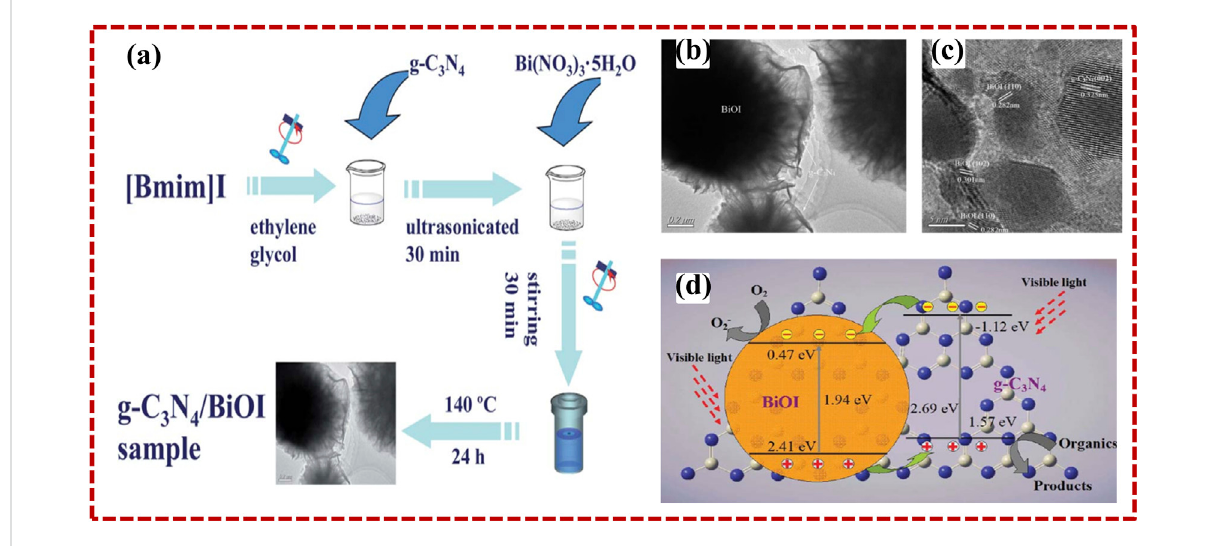
FIGURE 4 The synthesis method (A) , TEM (B) , and HRTEM (C) pictures of g-C 3 N 4 /BiOI. (D) The transferring mechanism of the photo-generated charge carriers across g-C